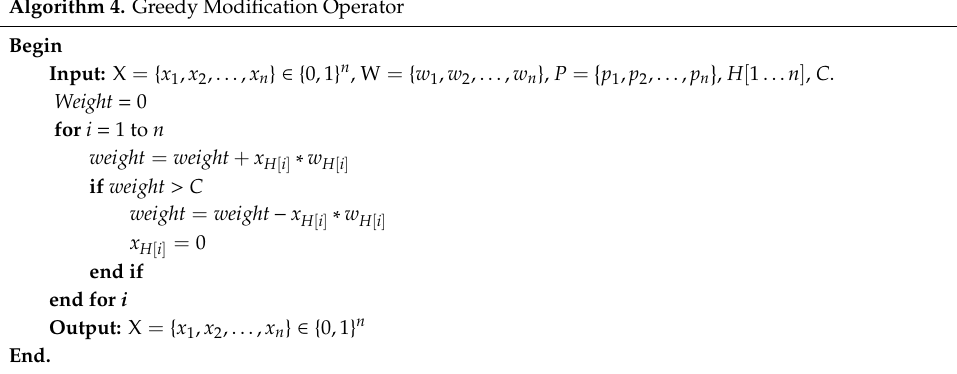
Algorithm 4. Greedy Modification